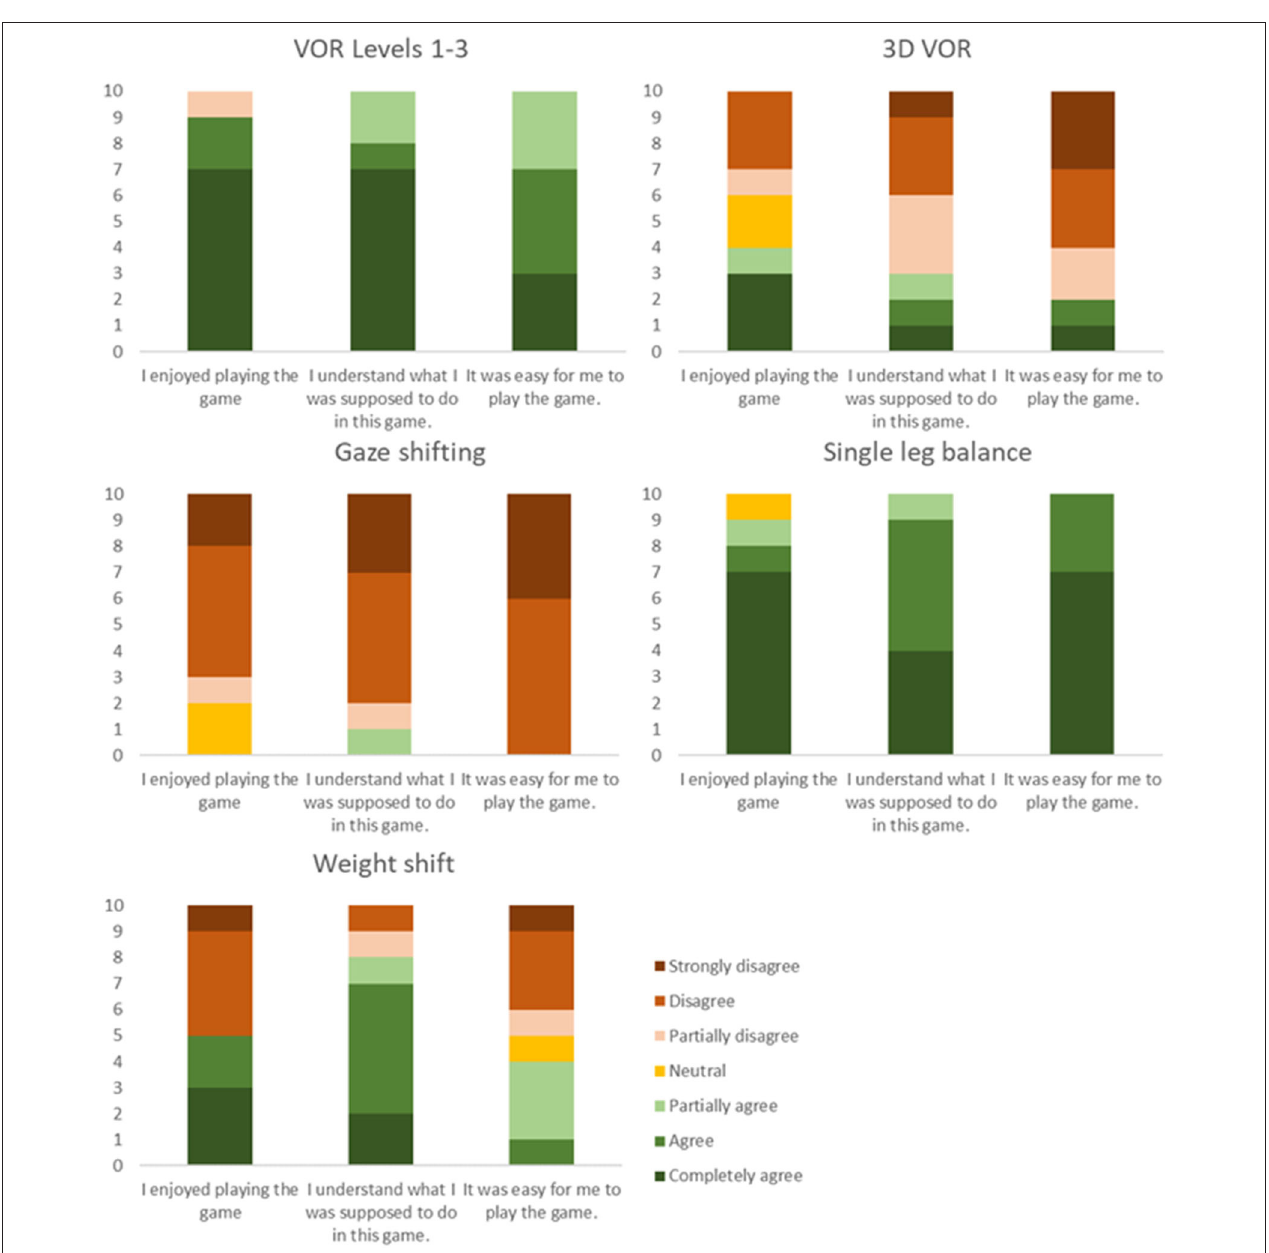
FIGURE 3 | Ratings of the different games, indicating the number of subjects agreeing or disagreeing with the statements.